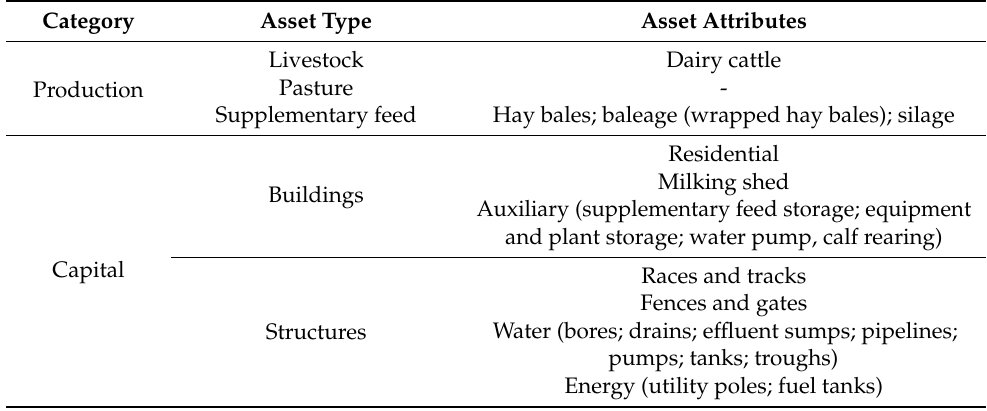
Table 2. On-farm production and capital asset categories and types exposure to flooding.